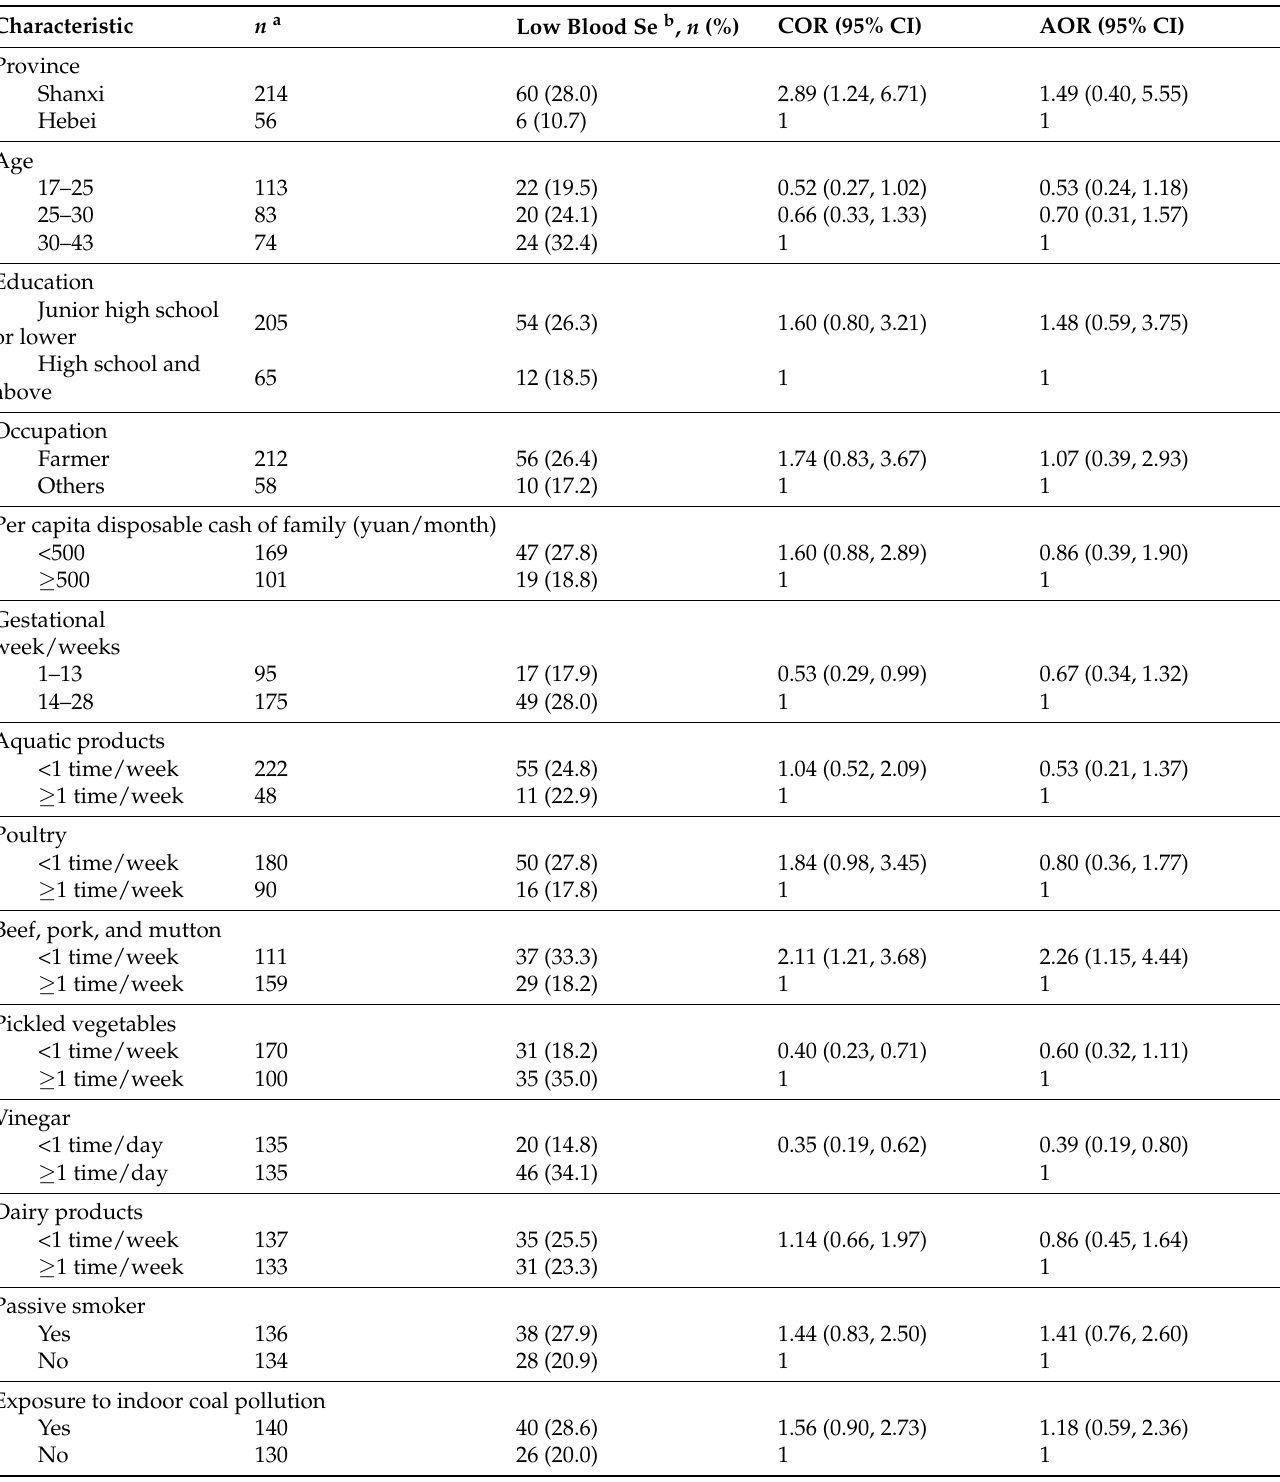
After adjusting for potential confounding factors in multivariate logistic models, the adjusted ORs for lower frequency of beef and pork/mutton and lower frequency of vinegar consumption were 2.26 (95% CI, 1.15, 4.44) and 0.39 (95% CI, 0.19, 0.80), respectively Table 3. Factors associated with relatively lower blood levels of Se among pregnant women in the first or second trimesters. Characteristic n a Low Blood Se b , n (%) COR (95% CI) AOR (95%